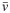
A comparison of tracking and DDM methods for a sample maintained at 37°C for 15 min and 50 min after thawing.(a,b) swimming speed distributions. Histogram of VAP (black) and VSL (grey) were calculated from 10 movies (10×, 100 fps, 500 p, 0.5 s) with ≈ 50 swimming tracks per movie. A lower magnification movie (2×, 300 fps, 500 p, 10 s) was recorded immediately afterwards and analysed with DDM to give v¯ (red vertical bar) and σ from which P(v) was reconstructed (red dashed line). Histograms are normalised such that the peak is at 1. (c,d) Head oscillation amplitude A0 and frequency f0 measured with DDM and tracking for consecutive movies of the same sample. Note that the quoted error for tracking is the standard deviation for measurements from 50 tracks, while that for DDM is a standard deviation of the mean for averaging over the values measured over a range of q values.